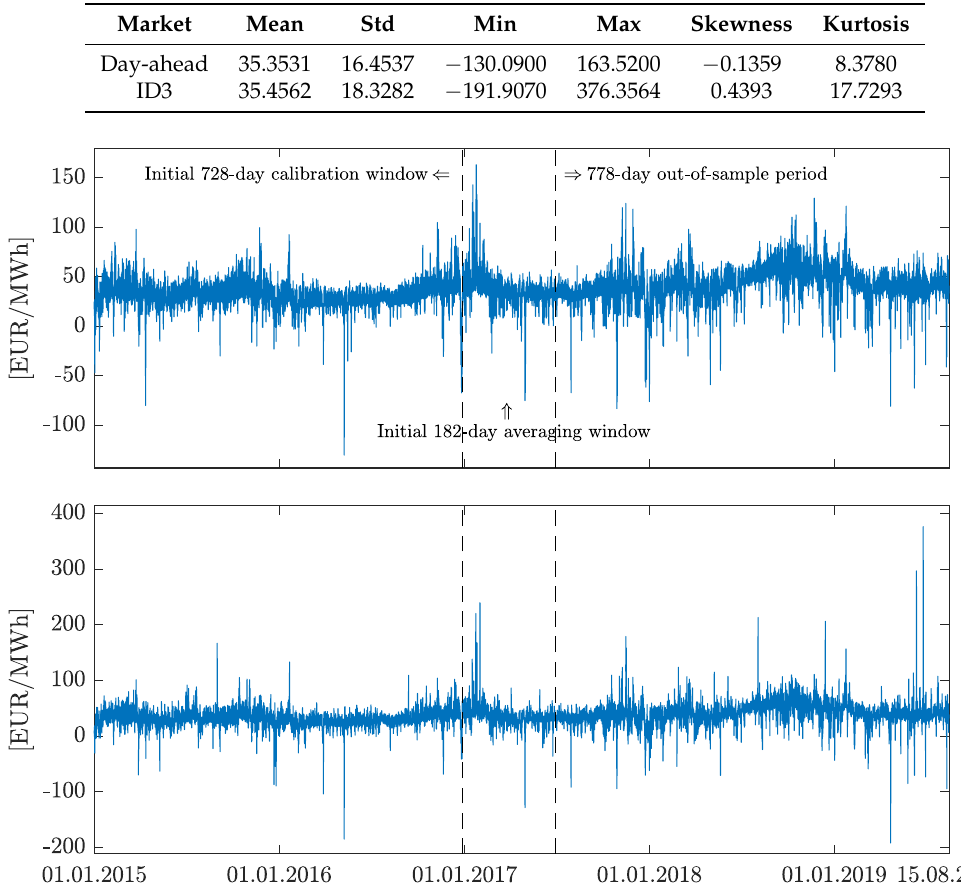
Table 1. Descriptive statistics of the time series of the electricity prices in Germany in period from 1 January 2015 to 15 August 2019.